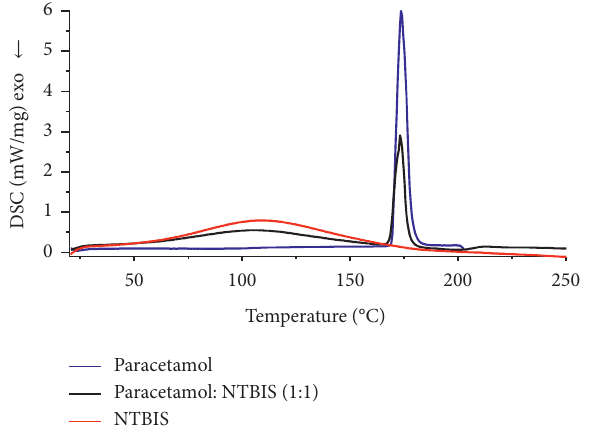
Figure 8: DSC thermogram of drug-excipient compatibility